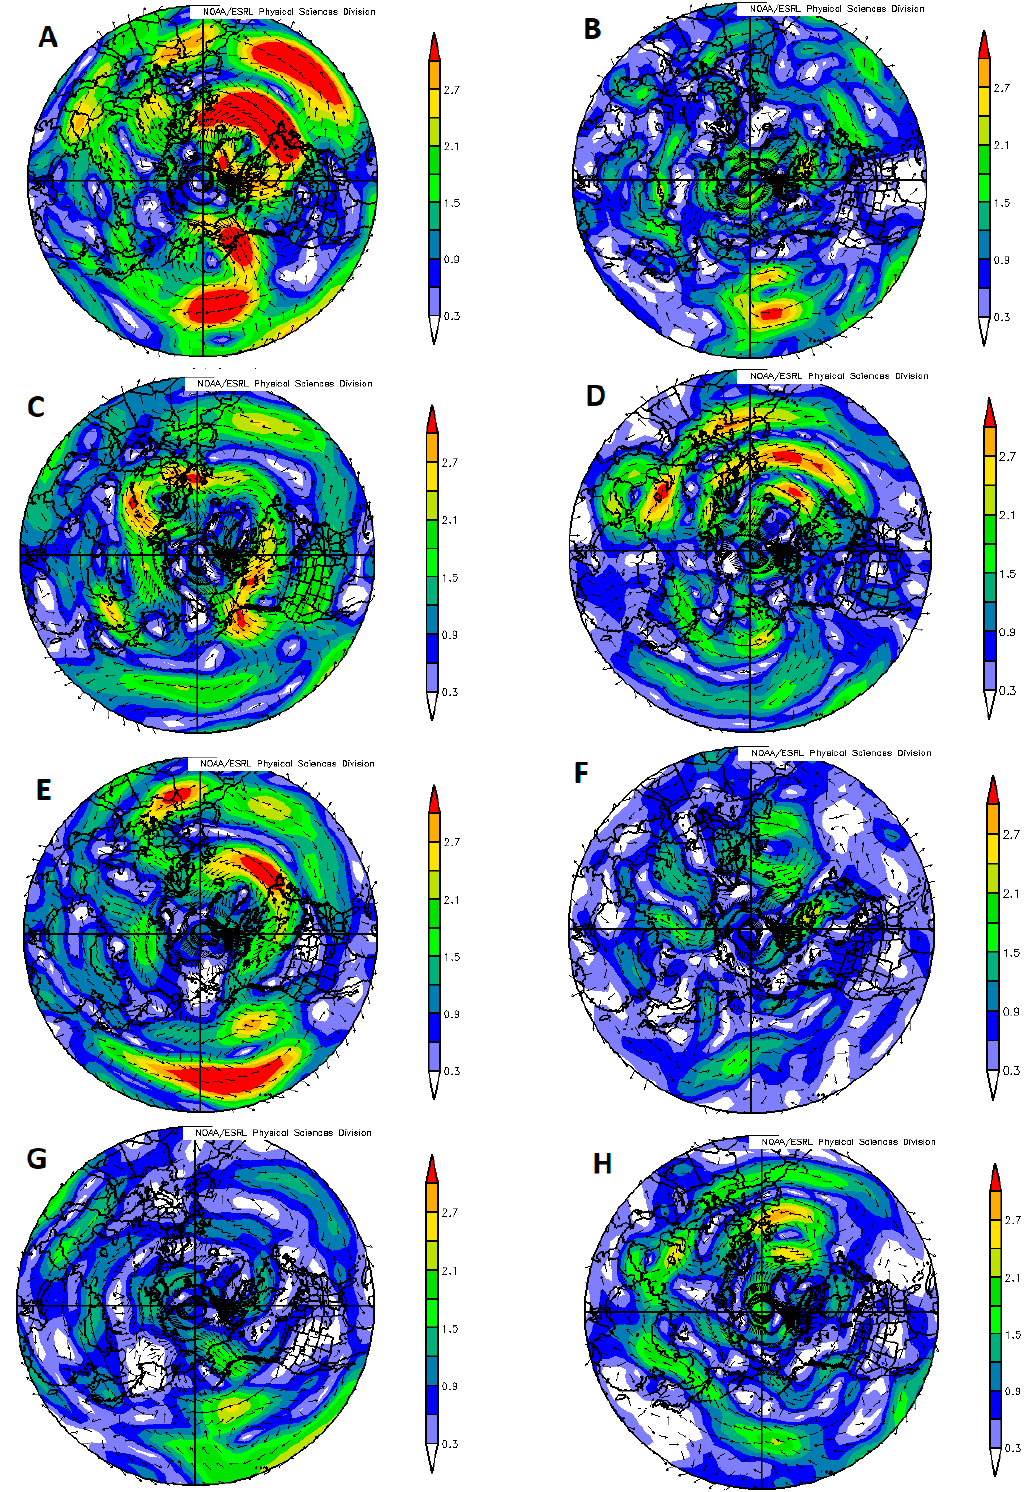
Figure 5. As in Figure 4, except for the 300 hPa vector wind anomalies (m s − 1 ). The winter season 5000 hPa anomalies (Figure 3A) resemble ‘state ‘ 1 (positive height) anomaly over Greenland – negative anomalies over the mid-latitude Atlantic) for the NAO and ‘state 2’ (positive height anomaly over the polar region, negative height anomalies in the mid-latitudes) for the AO from reference [62]. The summer season is similar, but weaker. The PNA index was negative in the winter and positive in the summer (Table 5) with the 500 hPa height anomalies reversing sign in the Gulf of Alaska region. The winter (summer) season 500 hPa anomalies also resemble the ‘state 1’ (‘state 2’) PNA in reference [62], or a positive (negative) height anomaly over the Bering Sea Region. Examining the 300 hPa meridional wind anomalies (Figure 4a,b) and vector wind anomalies (Figure 5a,b) also suggest strong meriodional flow, which was the strongest for the entire epoch (1957–2017). The P1 time period was associated with about 12 more days (6%) of high amplitude Type 3 and Type 4 flows on an annual basis in both regions. For the entire 1957–2017 period (Figure 6), there was eight fewer days of Type 3 and Type 4 flows per year in the NH. However, the long-term trend in the occurrence of zonal versus meridional flows over the entire period is consistent with the results of, for example reference [62] (see their Figure 10) and with the indexes in Table 5. The standard deviation was 12 and 10 days for the 1957–2017 period and P1, respectively. Treating the occurrence of Type 3 and Type 4 flow as a Baysean process (since the alternative is Type 1 and Type 2 flow) (e.g., reference [17], reference [28]), the observed occurrence of a more meridional flow regime was tested against the random probability for the occurrence of meridional flow. For the entire period and P1, the result was not statistically significant. The P2 years were characterized by the transition of the decadal modes for the NAO (1972) and the PDO (1976) to their positive phases. Again, all seasons in the southwest Russia region were cooler than that of the reference period. The 500 hPa height field (Figure 3c,d) for P2 is similar to that of P1, but there were stronger negative anomalies over the USA in the winter season. Additionally, Figure 4c,d and 5c,d support the results of reference [4], who suggested that conditions became more zonal during this period. The AO (Table 5) was generally negative across all seasons but smaller than for P1, supporting a more zonal NH epoch that P1 (see Figure 3c,d, 4c,d and 5c,d). The mean daily NAO was negative in the winter and positive in the summer over the Atlantic Region, while the PNA index was negative in both the summer and winter seasons over the Pacific. The winter season NAO and PNA still resembles the ‘state 1’ (and ‘state 2’ of the AO’) of reference [62] for both regions (see also Table 5). Also, Table 1 shows that the proportion of zonal flow days increased for both regions, resulting in a similar number of Type 3 and 4 flows versus more zonal Type 1 and 2 flow days per year as for the entire period (1957–2017). The standard deviation for the P2 period was 10 days. During P3, the decadal modes of the PDO and NAO were both in their positive phase throughout this period, although the NAO transitioned to the negative phase in 1996. The PDO transitioned to the negative phase in 1998. An examination of the AO supports (Table 5) the conclusion that this epoch was the most zonal across the NH as the index were now weakly positive during this epoch (see Figure 3e,f, 4e,f and 5e,f). Table 1 also shows that the number of zonal flow days increased in both study regions for this time period such that there were 50, and 14 more zonal flow Type 1 and 2 flow days (per year) observed in the southwest Russia and central USA regions,